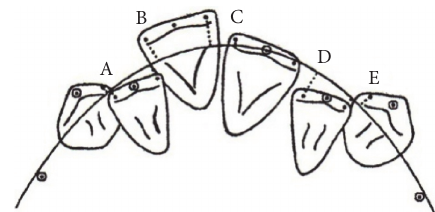
Figure 1: A template applied for measurement Little’s Irregularity Index [16]. The sum of linear displacement of anatomical contact points of six mandibular anterior teeth, expressed in mm: 0: per- fect alignment, 1–3 mm: minimum irregularity, 4–6 mm: moderate irregularity, 7–9 mm: severe irregularity, and 10mm and more: very severe